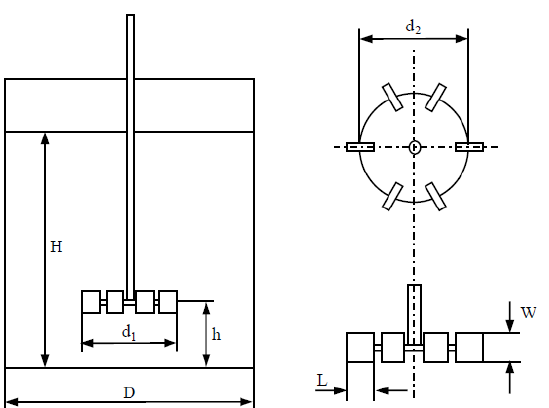
Figure 2. Stirrer design parameters. D: reactor diameter, d 1 : impeller diameter, d 2 : central disk diameter, W: blade with, L: blade length, H: filling reactor level, h: distance between the tank bottom and the impeller.